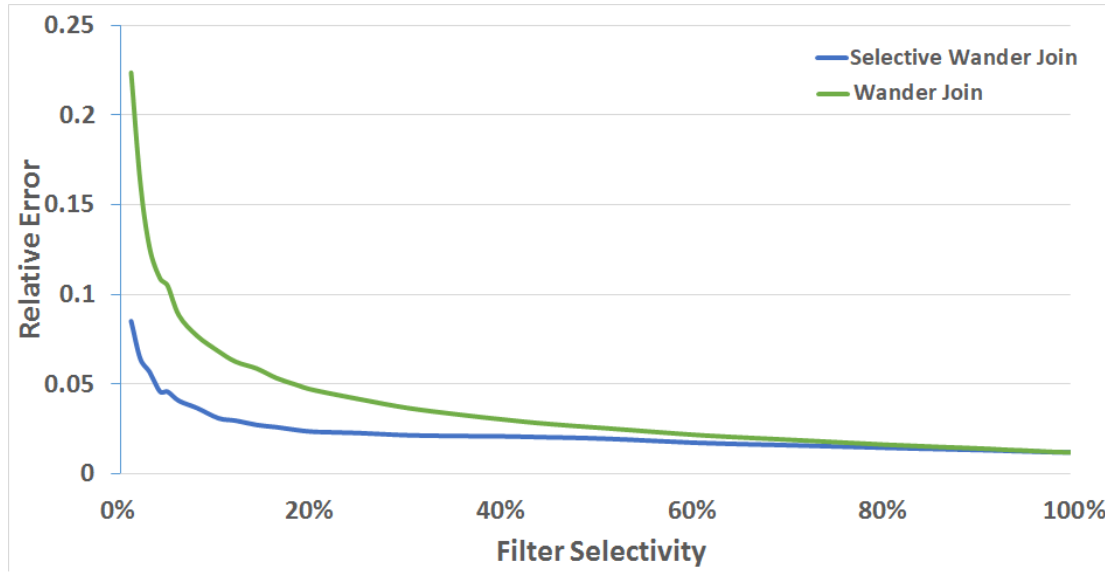
Figure 6. The relative error at 95% CI for both systems after 10,000 samples over various levels of selectivity for the TPC-H dataset. The lower the selectivity percentage, the slower the rate of convergence. By pruning out records that fail the filter, our relative error is less than standard Wander Join at 1% selective